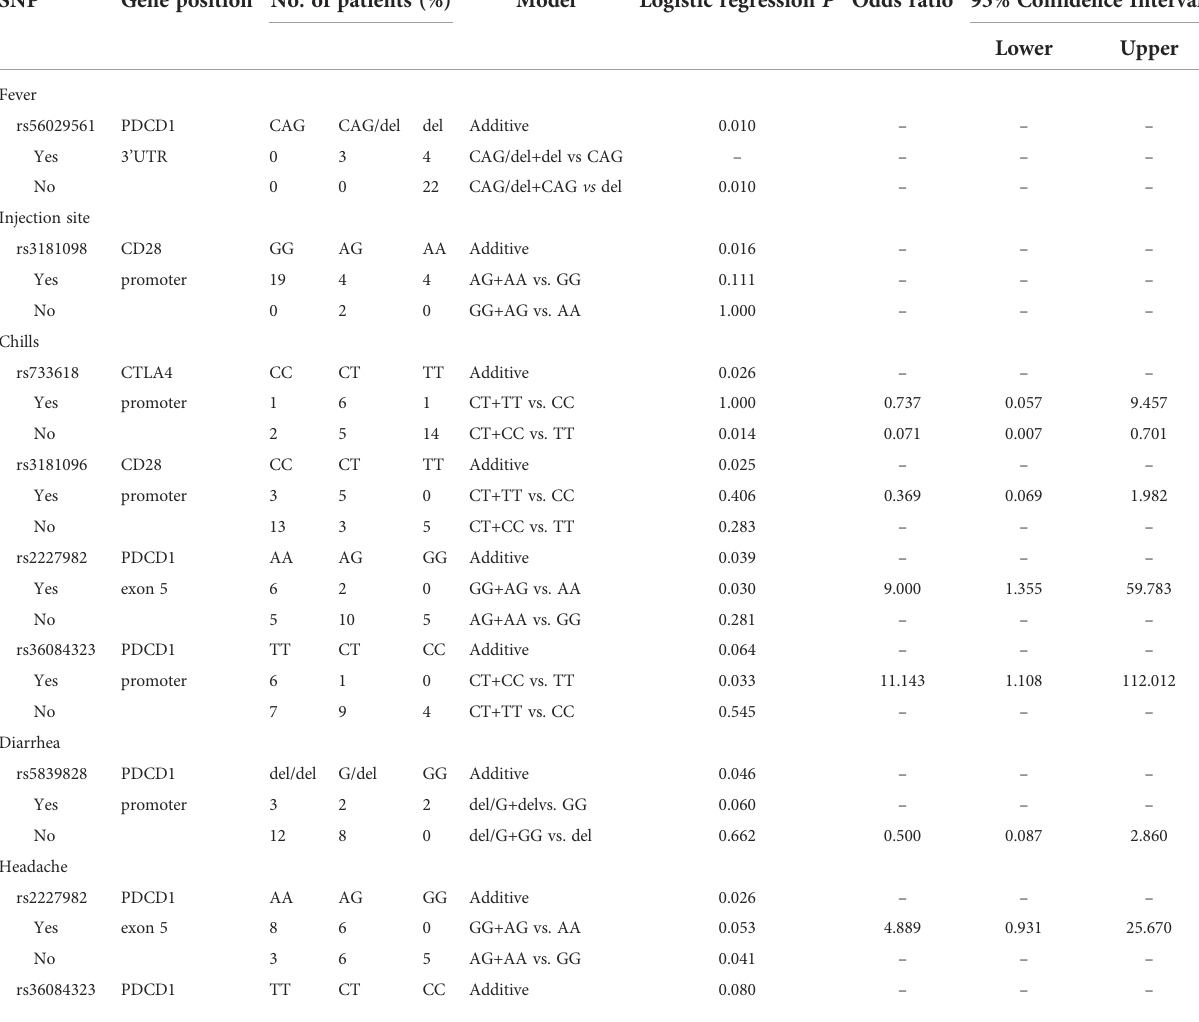
TABLE 3 Side effects with the fi rst dose of mRNA vaccines (Moderna +BNT). SNP Gene position No. of patients